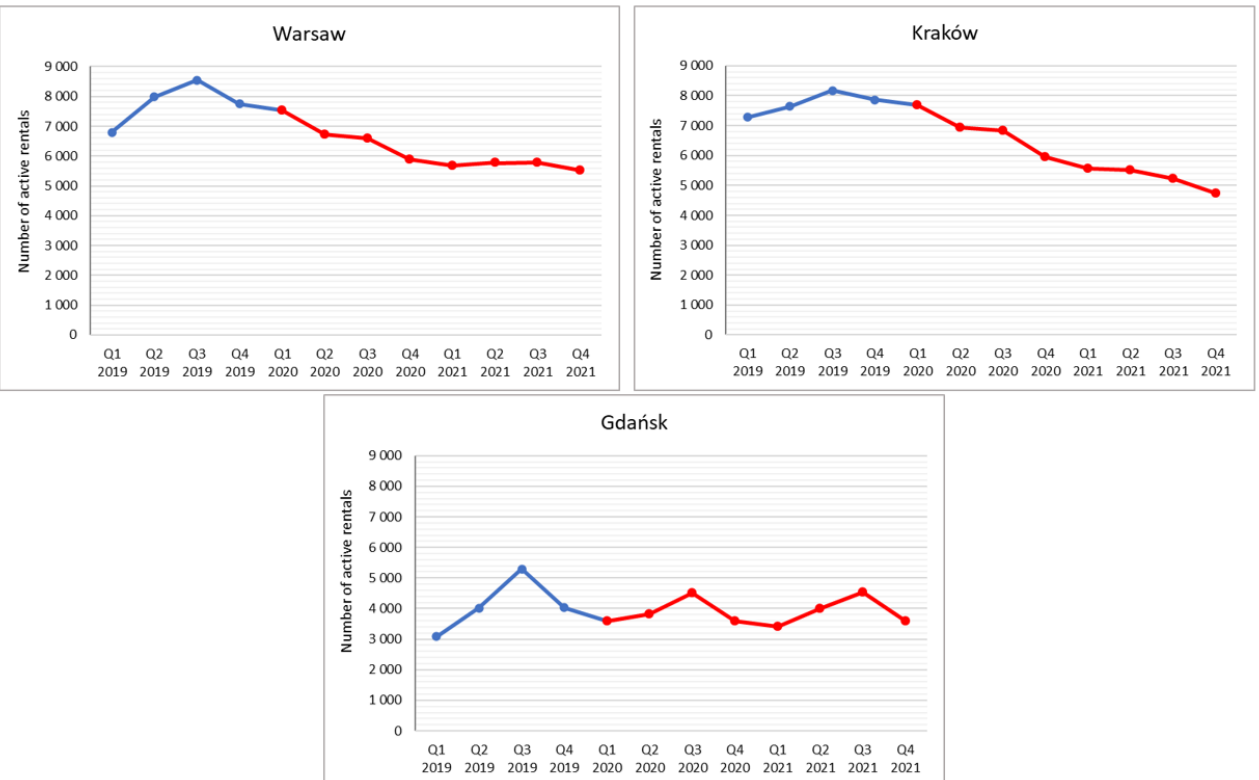
Figure 2. Number of active rentals by quarter (Q) (in cities with more than 3000 rentals).